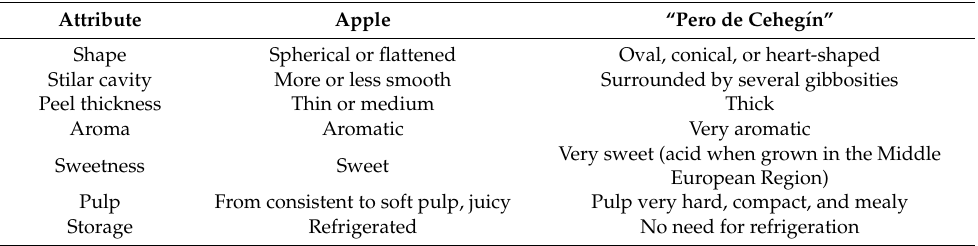
Table 1. Differences between apple and “Pero de Cehegín”. Table 1. Di ff erences between apple and “Pero de Ceheg í